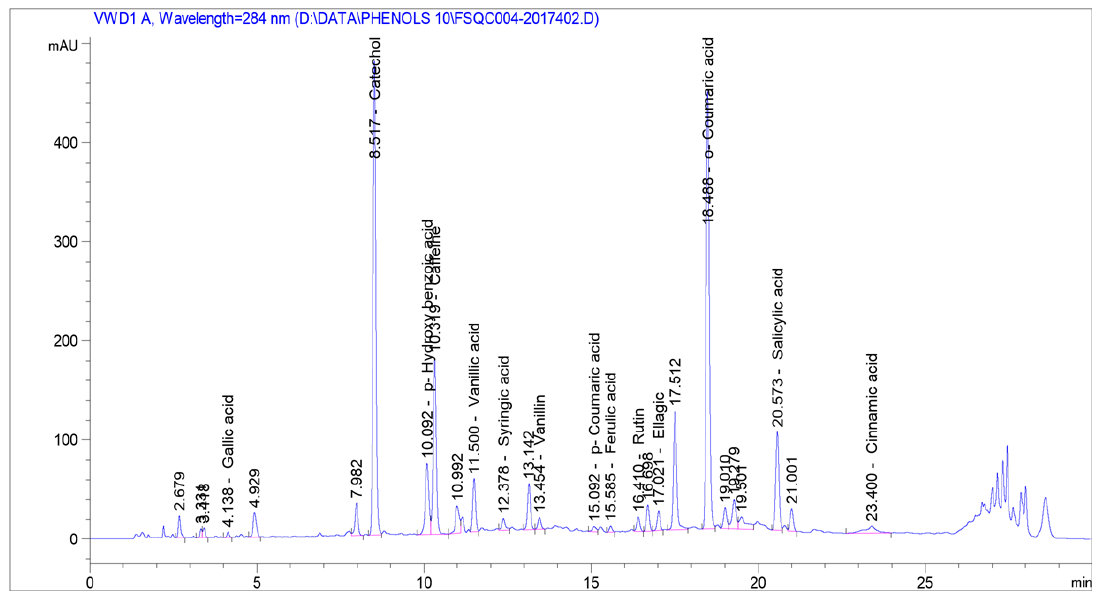
Figure 2. High-performance liquid chromatography (HPLC) chromatogram of phenolic compounds in Rosmarinus officinalis. L. (detection at 284 nm). X -axis = retention time, min = minutes; and Y -axis = detector signal.